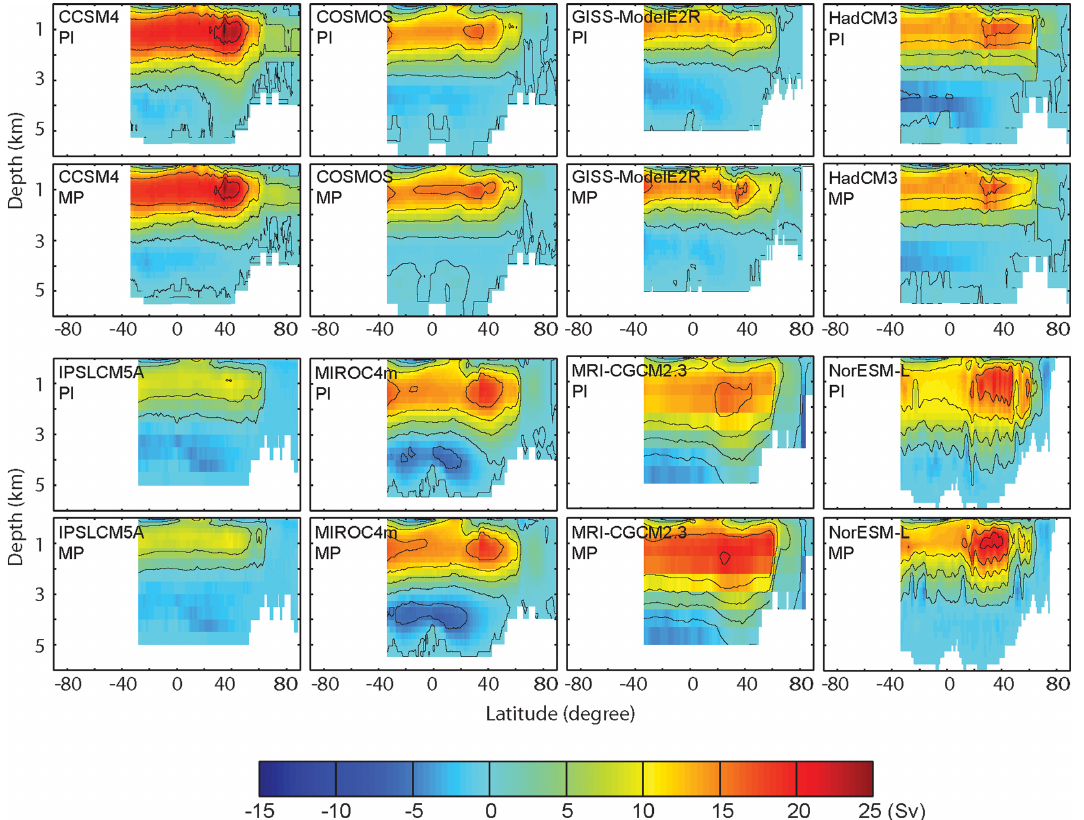
Fig. 2. Comparison of pre-industrial (PI) and mid-Pliocene (MP) Atlantic overturning streamfunctions (Sv) simulated in the PlioMIP. The interval of black contours is 5Sv.